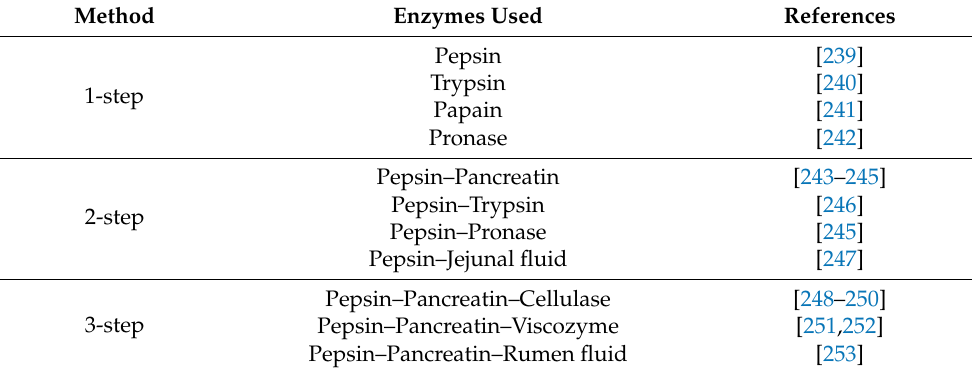
Table 12. Summary of one-, two-, and three-step closed in vitro filtration methods (adapted from